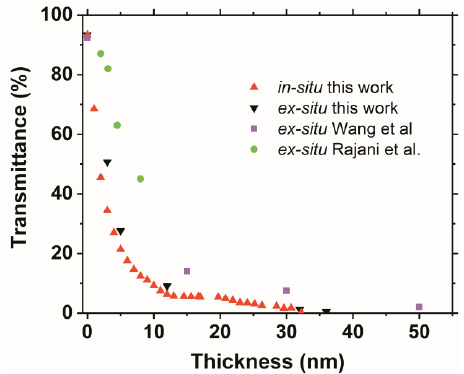
Figure 5. Evolution of the transmittance values at 550 nm wavelength extracted from the spectral data acquired during Cr film growth. The in situ and ex situ data of this study (triangles) are plotted in comparison with ex situ data by Wang [18] (squares) and Rajani [3] (circles).